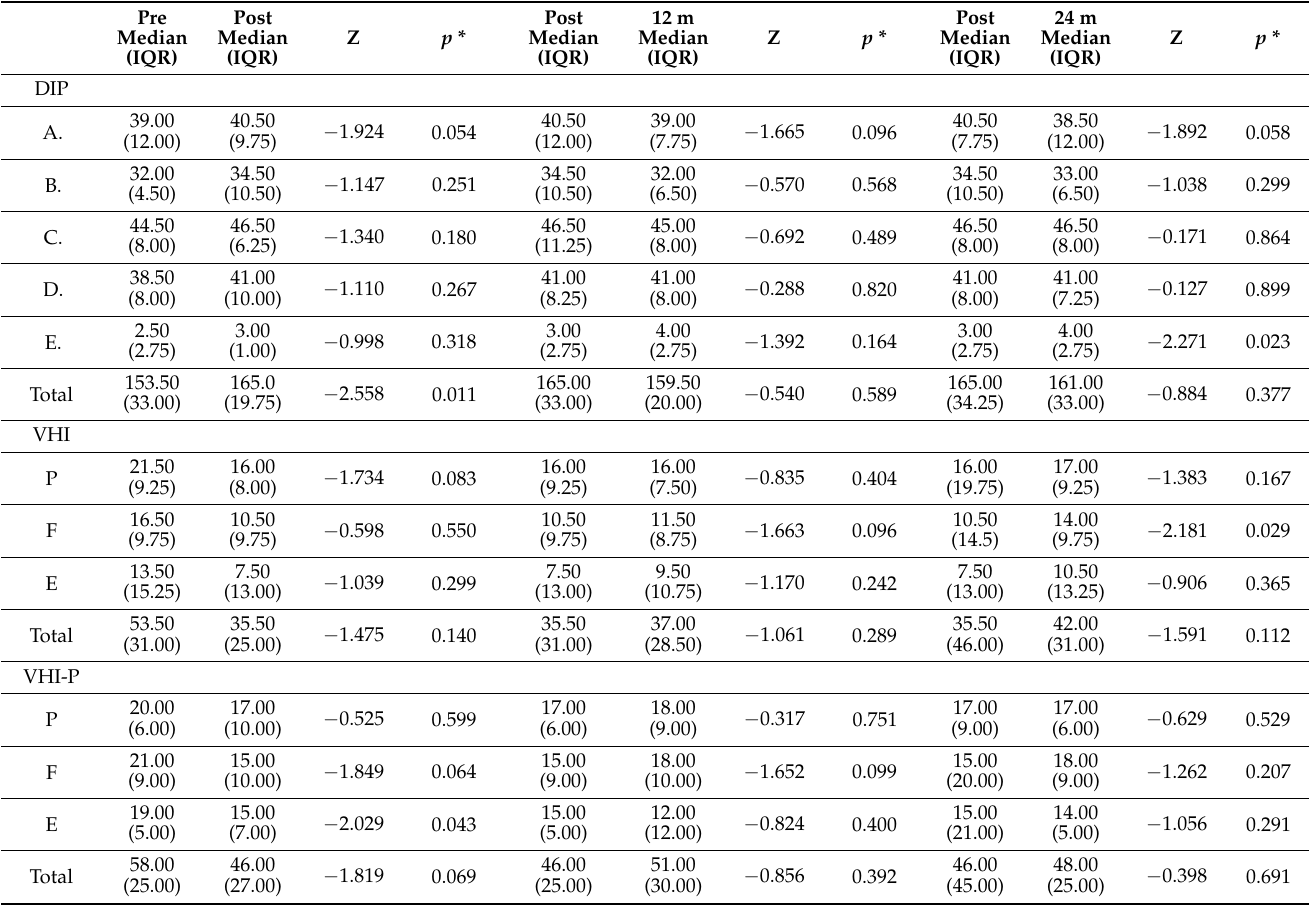
Table 3. Analysis of planned comparisons for DIP, VHI, and VHI-P from pre-to-24 months post-